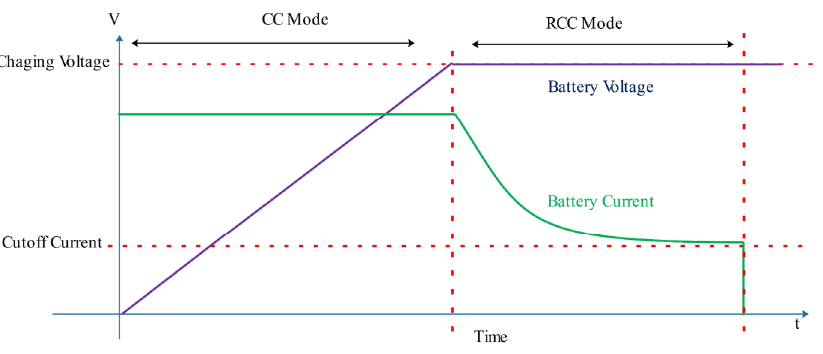
Figure 5. Current and voltage waveforms in the proposed CC/RCC are a charging scheme.